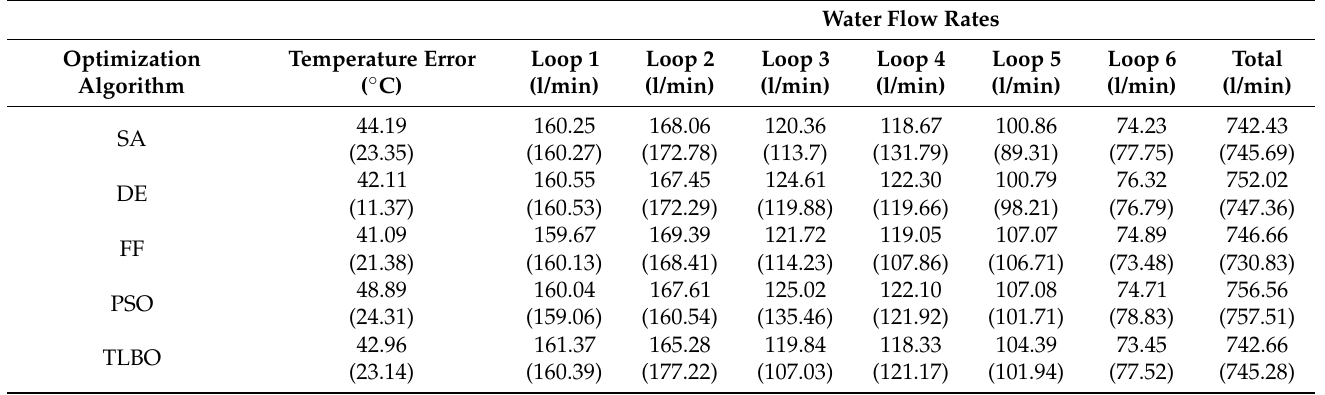
Table 3. Mean-value temperature errors and water flow rates and the best temperature error and water flow rates (values in the brackets) for each algorithm for the casting speed of 2.78 m/s.